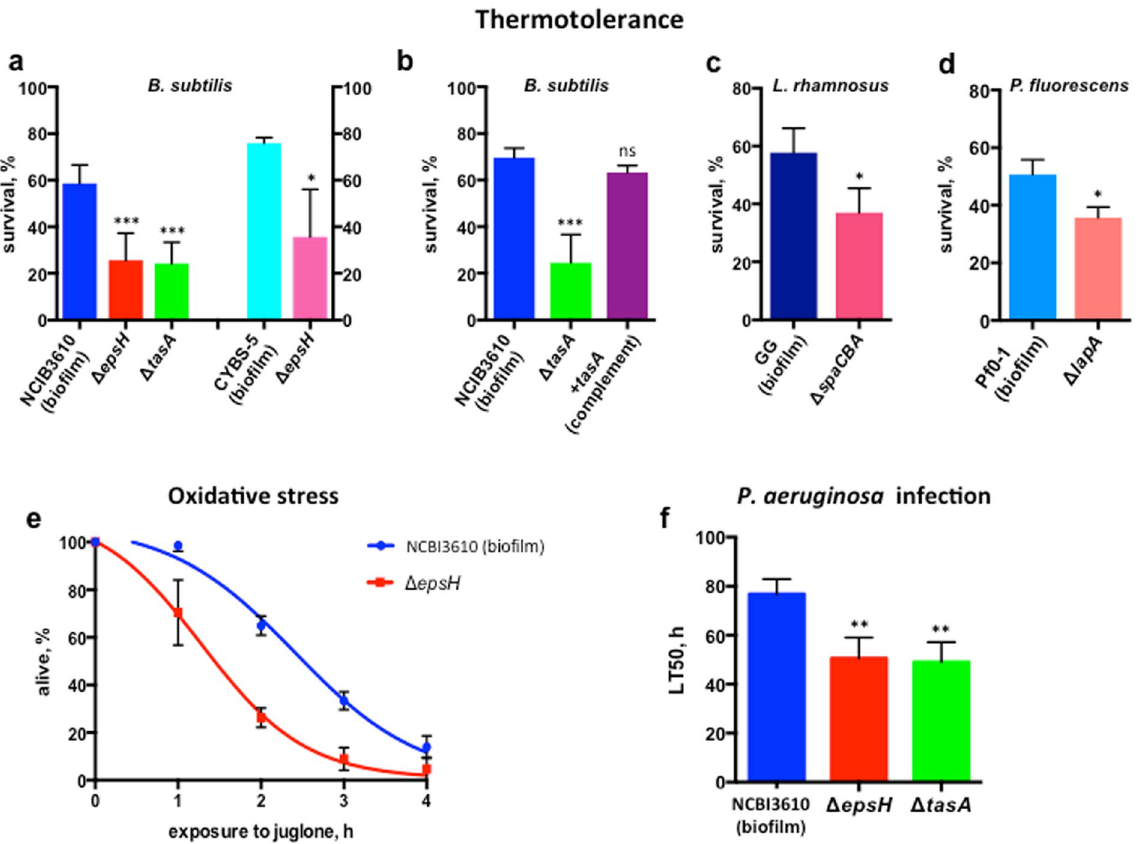
Figure 1. Biofilm enhances C. elegans stress resistance. Each graph represents mean values ± SD from at least free independent biological replicates. Each biological replicate was performed with at least 60 worms per condition. ( a ) B. subtilis biofilm increases C. elegans thermotolerance. left panel, Day-five-adult worms grown on B. subtilis NCBI3610 (biofilm) or its biofilm-deficient mutants, Δ epsH and Δ tasA , were subjected to heat shock at 33 °C for 3 hours. Surviving animals were scored after 20 hours of recovery at 20 °C. Mean values ± SD are plotted, n = 5. right panel, C. elegans were grown on B. subtilis CYBS-5 (biofilm) or its biofilm-deficient derivative ( Δ epsH ) until day 5 of adulthood and subjected to heat shock at 33 °C for 3 hours. Surviving animals were scored after 20 hours of recovery at 20 °C. T-test p-value = 0.0270, n = 3. ( b ) Complementation of B. subtilis tasA deficiency restores biofilm-mediated enhancement of C. elegans thermotolerance. Worms were grown on either biofilm-forming NCBI3610 B. subtilis (biofilm), its biofilm-deficient derivative ( Δ tasA ), or ∆ tasA complimented with a copy of tasA inserted at a distal locus ( + tasA (complement)). Five-day old adult worms were heat shocked and scored as described in ( a ), n = 3. ( c ) The Lactobacillus rhamnosus biofilm enhances worms resistance to elevated temperatures. C. elegans were grown on Lactobacillus rhamnosus GG (biofilm) or its biofilm-deficient derivative ( Δ spaCBA ) until day 5 of adulthood and subjected to heat shock at 36 °C for 3 hours. After 20 hours of recovery at 20 °C it was unclear if animals were dead due to residual movement, thus surviving animals were scored after 40 hours of recovery at 20 °C. T-test p-value = 0.0389, n = 3. ( d ) The Pseudomonas fluorescens biofilm promotes worm heat shock-resistance. C. elegans were grown on Pseudomonas fluorescens Pf0-1(biofilm) or its biofilm-deficient derivative ( Δ lapA ) until day 5 of adulthood and subjected to heat shock at 35 °C for 4 hours. Surviving animals were scored after 20 hours of recovery at 20 °C. T-test p-value = 0.0144, n = 3. ( e ) The biofilm renders C. elegans more resistant to oxidative stress. Five-day old C. elegans , grown on NCBI3610 (biofilm) or its biofilm-deficient derivative ( Δ epsH ) were transferred to plates supplemented with juglone (90 μ M) and scored for survival every hour. For statistical data see Supplementary Table S1, n = 4. ( f ) B. subtilis biofilm protects against pathogenic bacteria. Five-day old worms fed NCBI3610 (biofilm) or its biofilm-deficient derivatives, Δ epsH and Δ tasA , were transferred to P. aeruginosa PA14 seeded plates and scored for survival every 6 hours. LT50, the time at which 50% of animals were scored as dead, was taken from Kaplan-Meier survival curves (median survival data). For the log-rank test p-values see Supplementary Table S2, n =